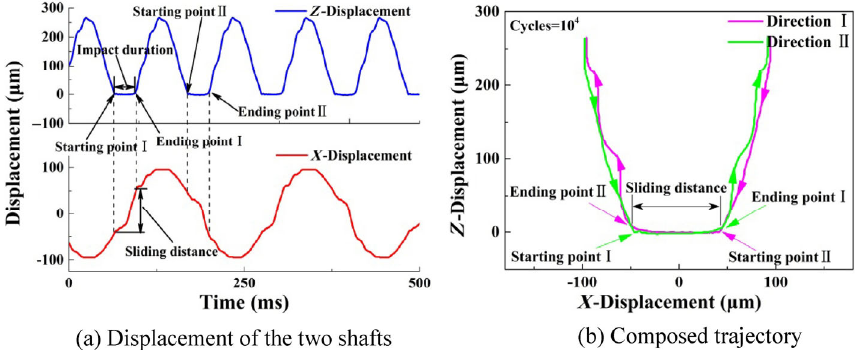
Fig. 8 Real displacement of the two directions and its composed trajectory under reciprocating